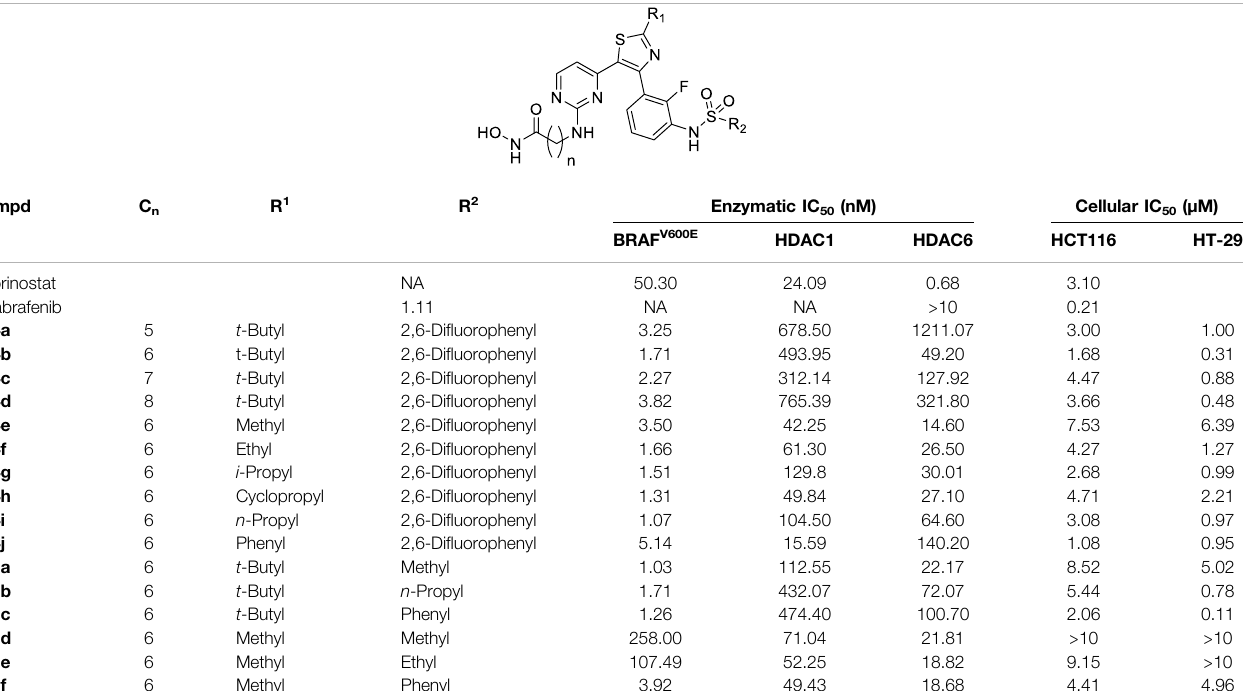
TABLE 1 | Enzymatic and cellular activities of compounds. a,b